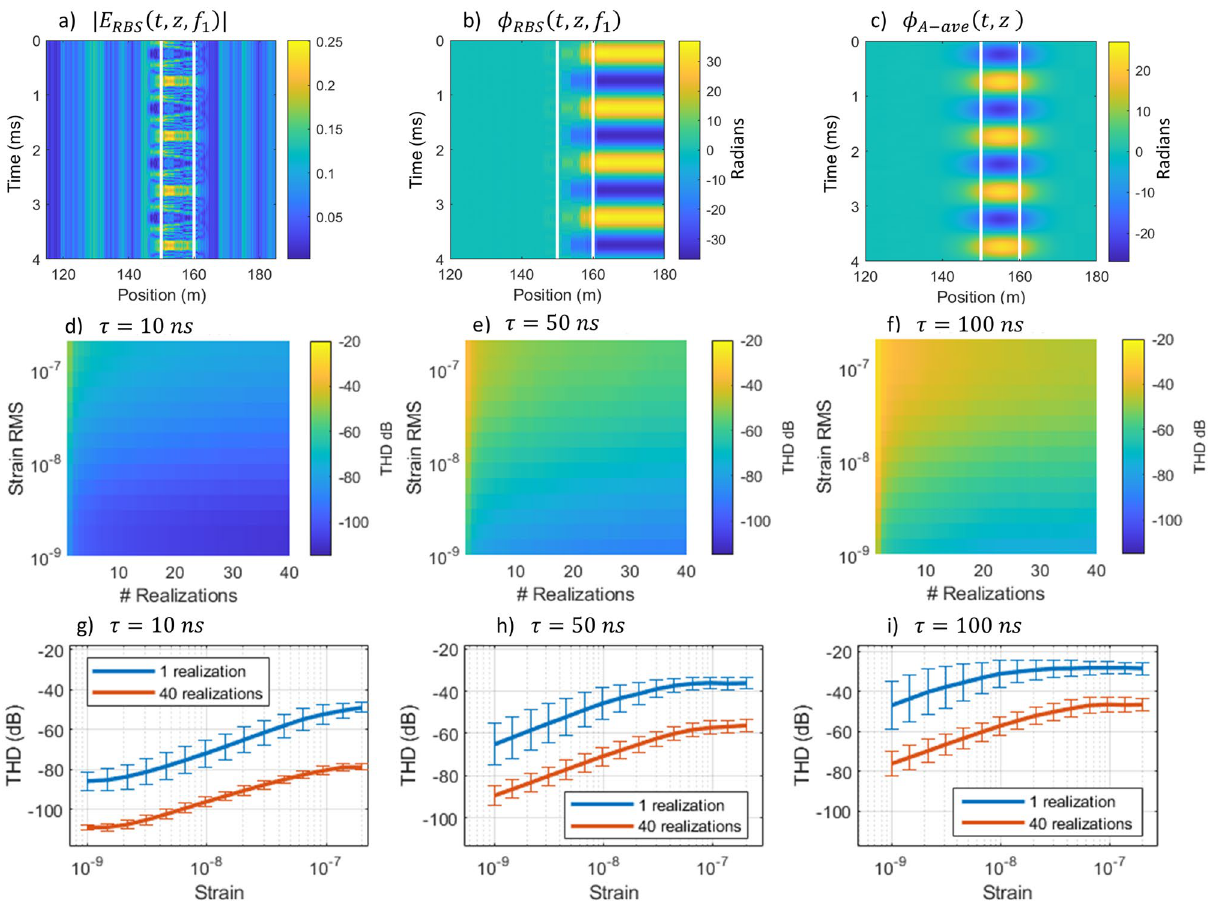
Figure 2. Results from simulations based on Rayleigh backscattered light from a 1 km FUT probed with a multi-frequency pulse train. The simulated amplitude ( a ) and phase ( b ) of an individual frequency component as a function of position along the fiber. ( c ) The aperture phase averaged over 40 frequency components. THD as a function of strain amplitude and number of realizations for 10 ( d ), 50 ( e ), and 100 ( f ) ns. Cross-sections